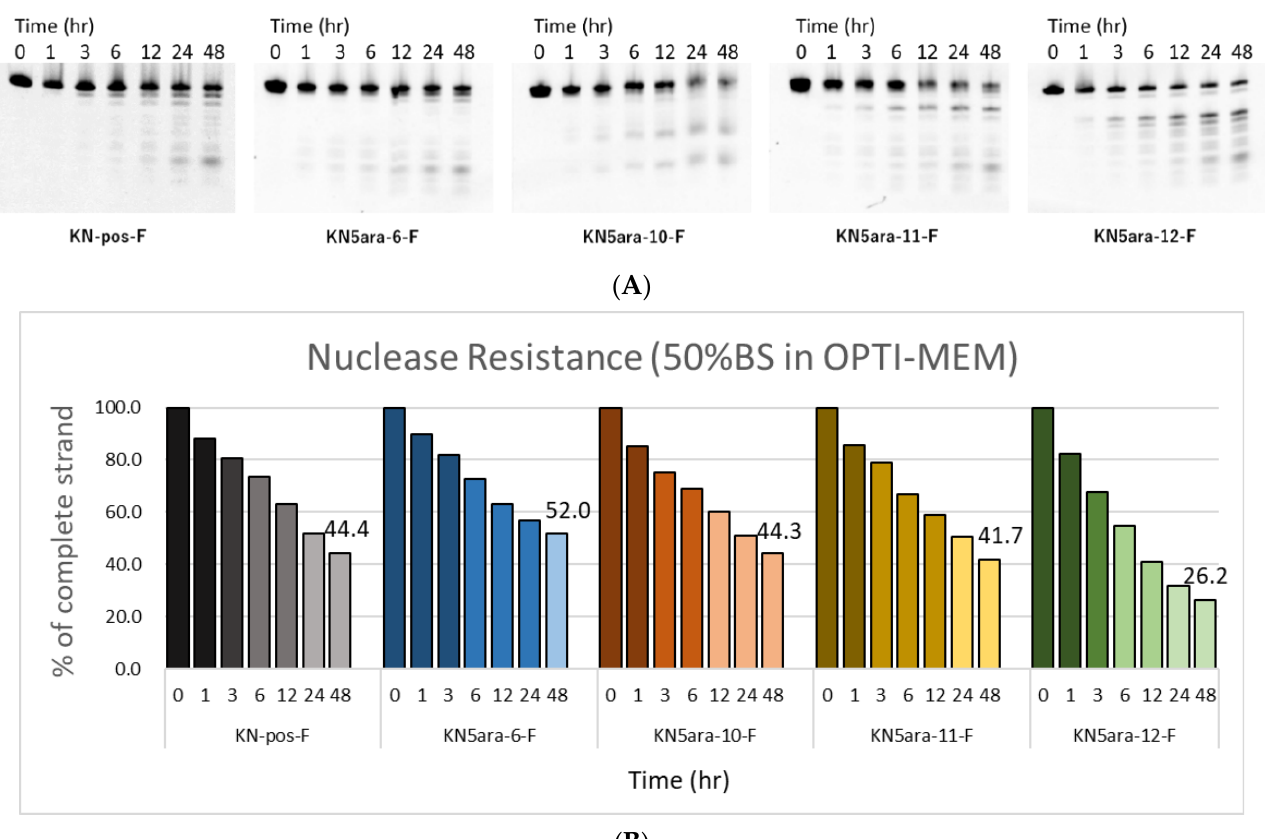
Figure 3. PAGE analysis of single-stranded KN5ara gapmers treated with OPTI-MEM containing 50% bovine serum (BS). Fluorescein-labeled KN5ara gapmers (300 pmol) were incubated in OPTI-MEM containing 50% BS. The reaction mixtures at various incubation time (0, 1, 3, 6, 12, 24, and 48 h) were analyzed by 20% PAGE containing 7 M urea and quantified by luminescent image analyzer LAS-4000 (Fujifilm). ( A ) PAGE images obtained from luminescent analysis. ( B ) Percentage of complete gapmer strands remaining at each time point, analyzed via ImageJ.